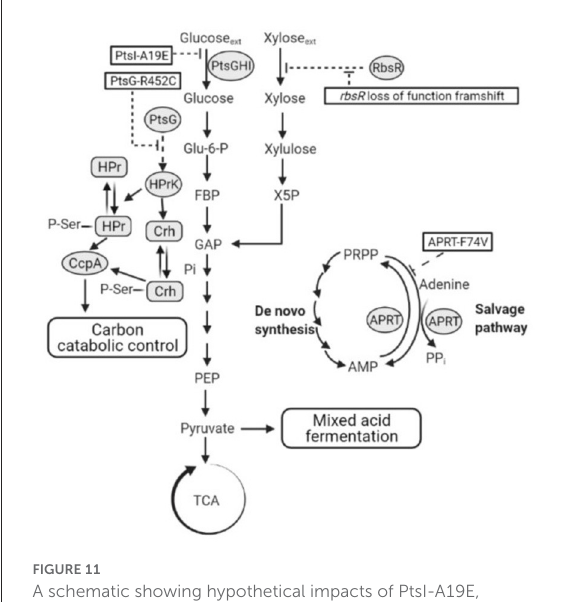
FIGURE11 A schematic showing hypothetical impacts of PtsI-A19E, PtsG-R452C, and APRT-F74V mutations, and the rbsR loss of function frameshift mutation, respectively. Dotted lines are hypotheses proposed in this study. PtsGHI, glucose-specific phosphoenolpyruvate:sugar phosphotransferase system (PTS); RbsR, ribose operon repressor; TCA, tricarboxylic acid cycle; ACS, acetyl-CoA synthetase; APRT, adenine phosphoribosyl transferase; PRPP, adenine and phosphoribosyl pyrophosphate; AMP, adenosine monophosphate; CoA, coenzyme A; HPr, phosphocarrier protein HPr; Crh, HPr-like protein Crh; CcpA, catabolite control protein A; HPrK, HPr